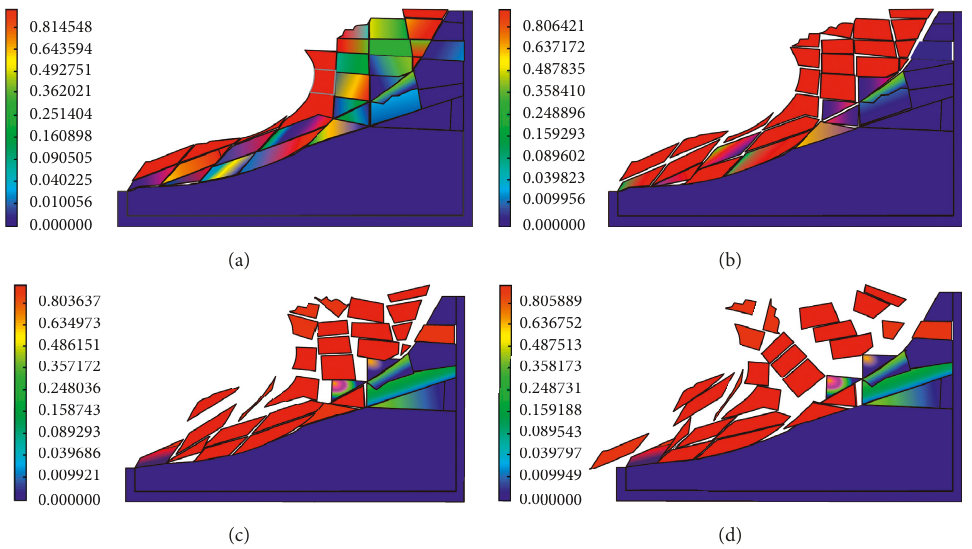
Figure 10: Second failure process of the northern slope in the Fushun West Open-Pit Mine: (a) step 1.892 × 10 6 ; (b) step 1.894 × 10 6 ; (c) step 1.896 × 10 6 ; (d) step 1.898 × 10 6